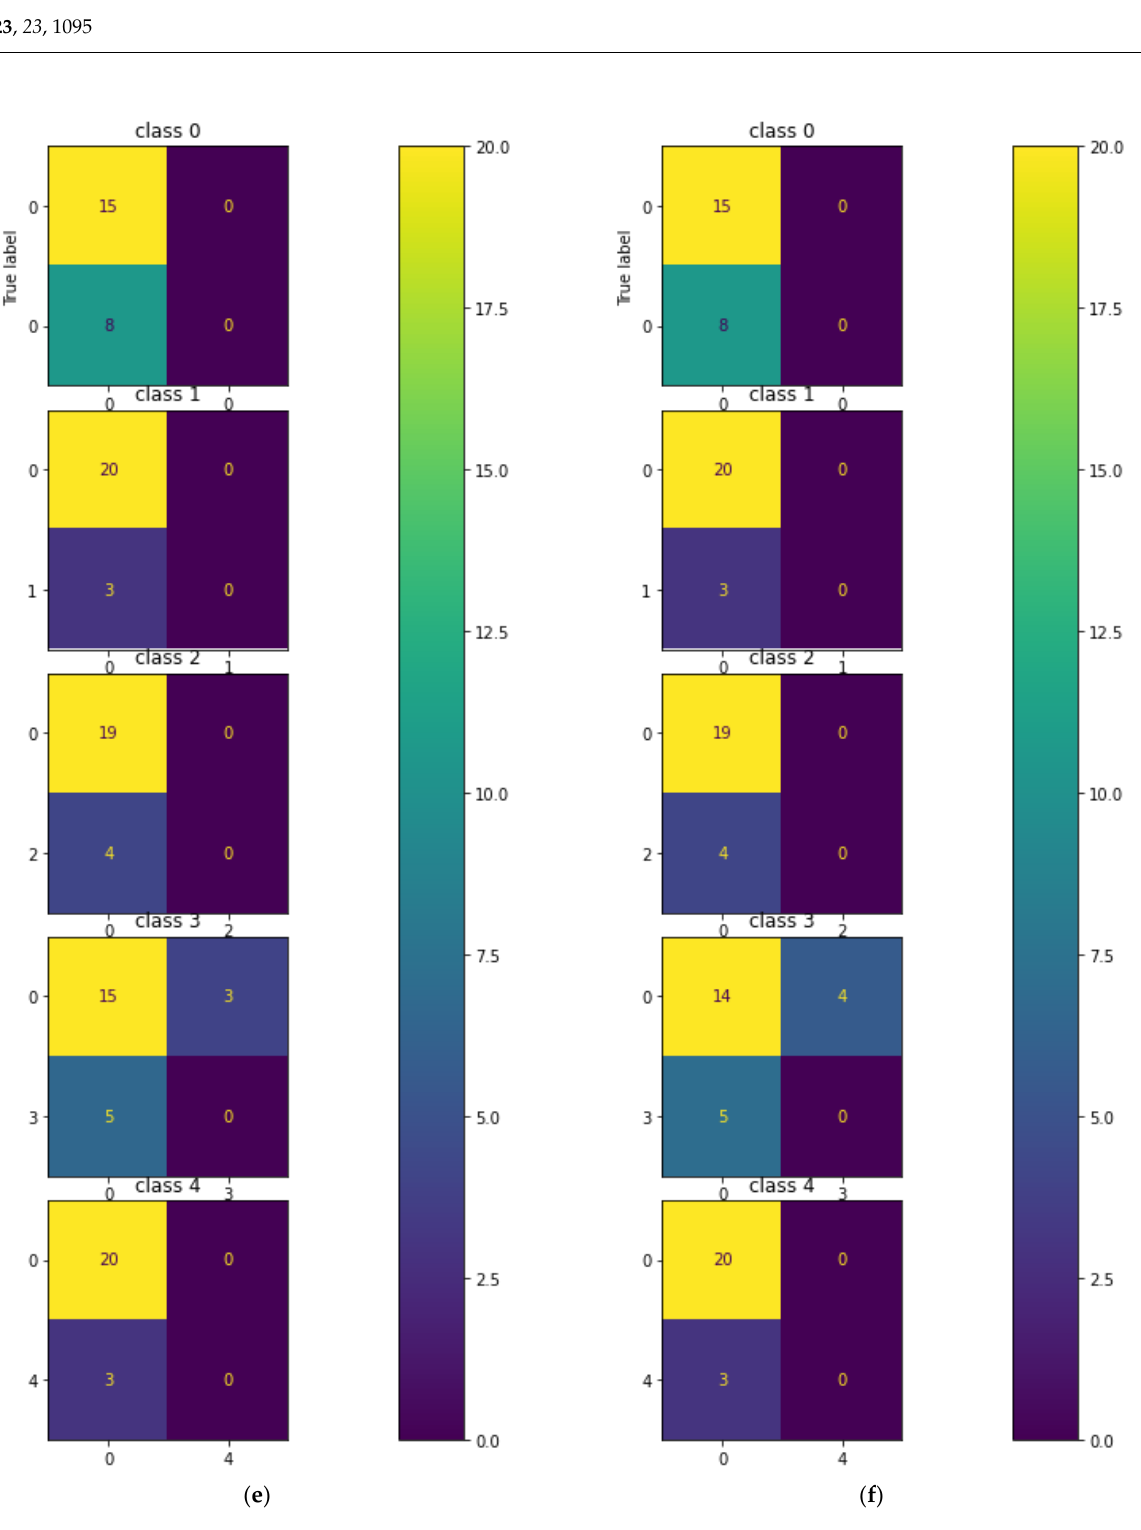
Figure 8. Multi-class confusion matrix for the hologram dataset: ( a ) CNN; ( b ) KNN; ( c ) MLP; ( d ) DT; ( e ) RF; ( f ) ET. ( e ) RF; ( f )